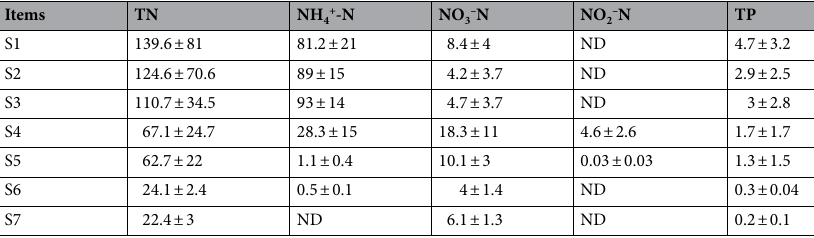
Table 2. Analysis results of macro organic pollutants at each sampling point (mg L −1 ). S1-S7 Sample point